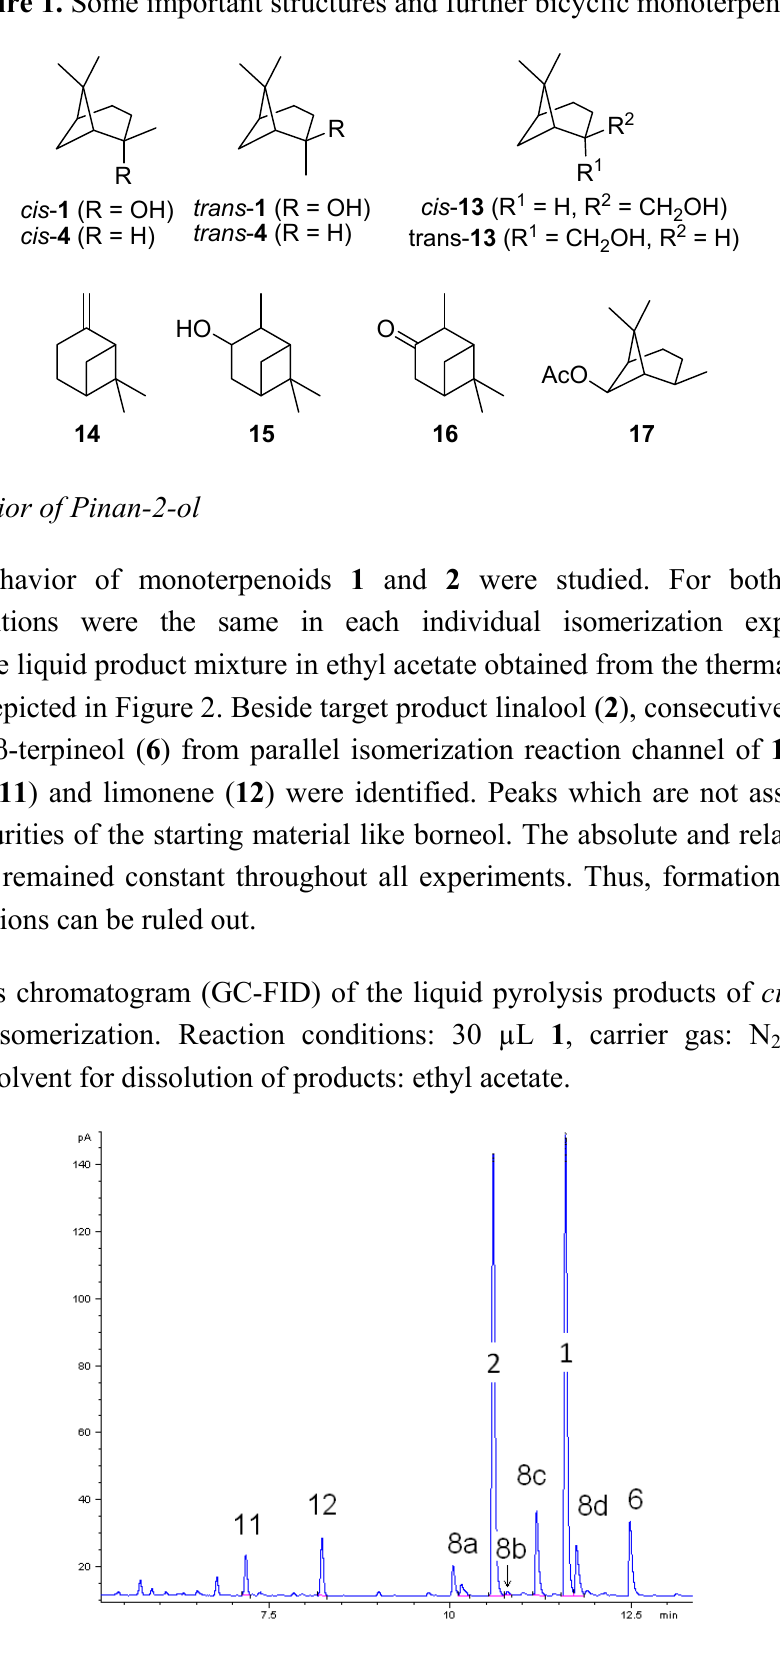
Figure 1. Some important structures and further bicyclic monoterpenes.